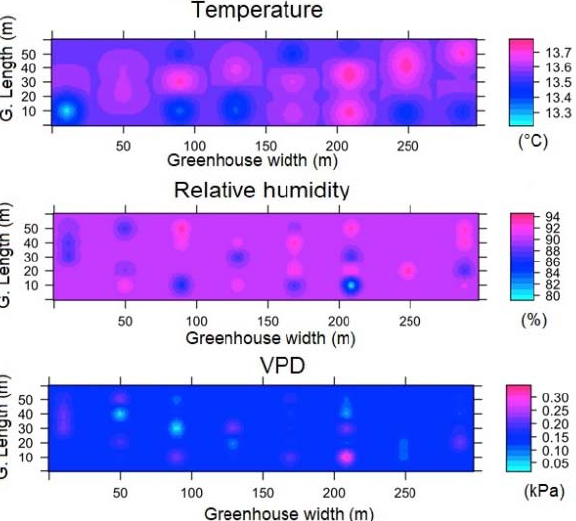
Figure A7. Spatial distribution predicted by kriging, for temperature, relative humidity and VPD in SG and for ESRL 2.